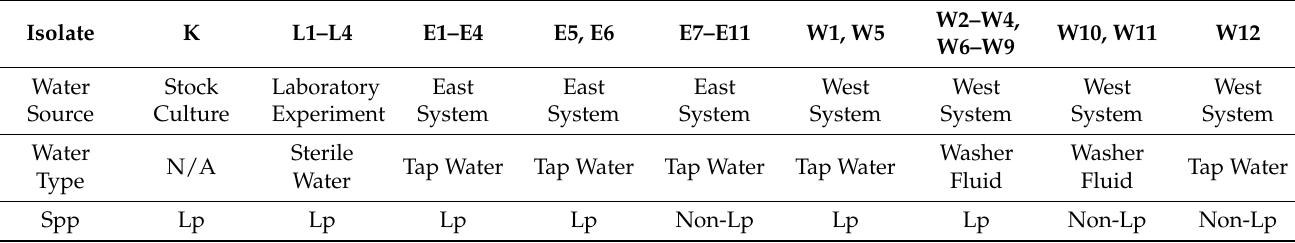
Table 1. Isolates of Legionella used in the study a